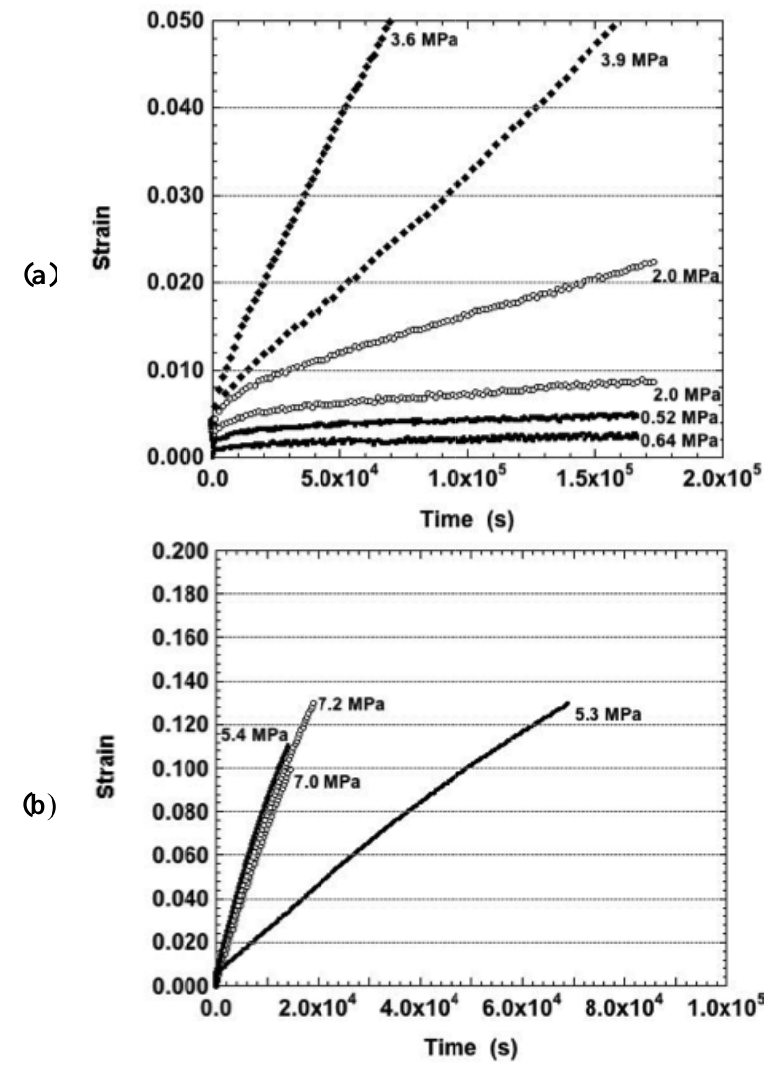
012 , 5 e 5. The s strain-time curves of condit tion and at a ure of 160 °C ( b ) 6.0